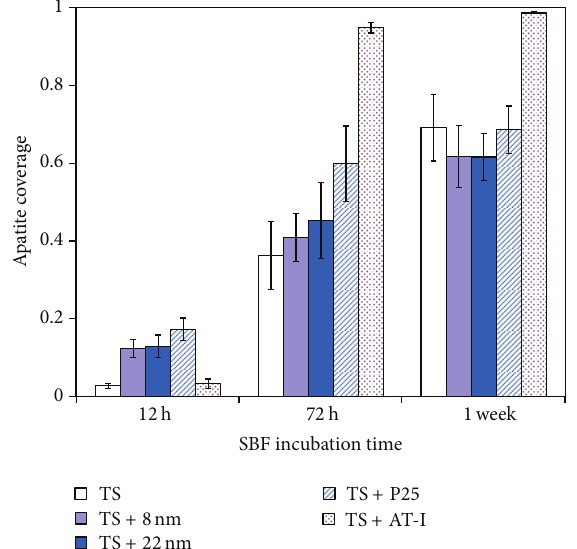
Figure 7: Apatite coverage on different surfaces after immersion in SBF solution for 12h, 72 h, and 1